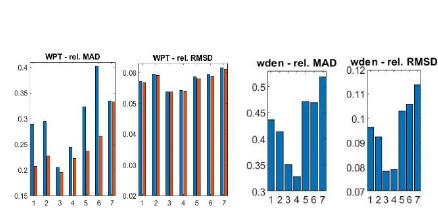
Figure 20. Comparison of rel. MAD and rel. RMSD for all 3 methods of denoising test sig- nals in steady case: mean signal method (blue), WPT method (without edges) (green) and wden method (red). (a) results of all mean signal method applied on a 7 period signal; (b) result of mean signal method applied on 50 period sig-